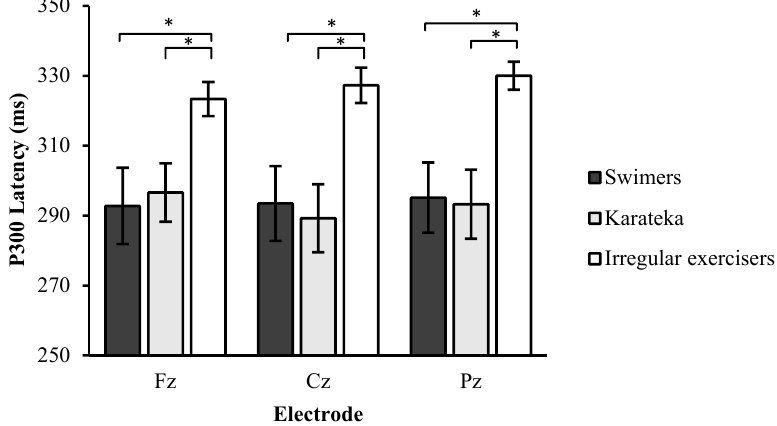
Figure 2. Mean P3 latency from the swimmers, karateka, and irregular exercisers during the auditory oddball task. * significant difference at p > 0.05.